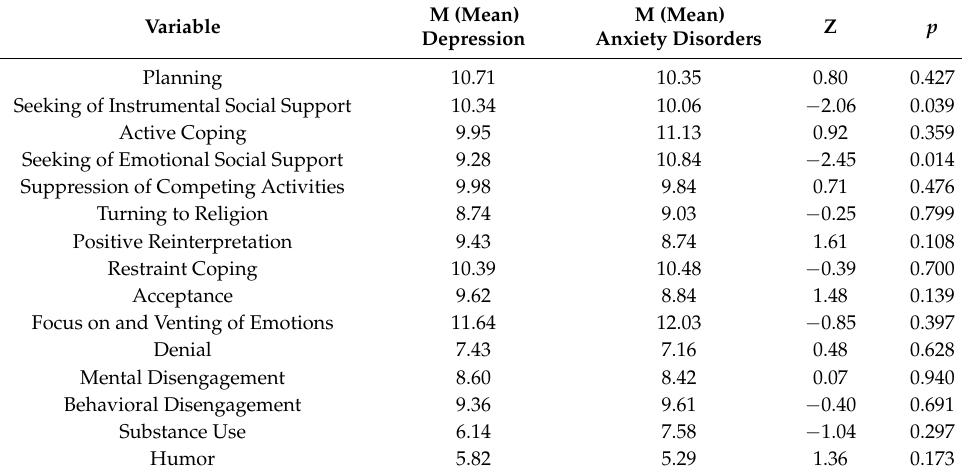
Table 3. Differences between patients with depression and subjects with anxiety disorders in stress coping